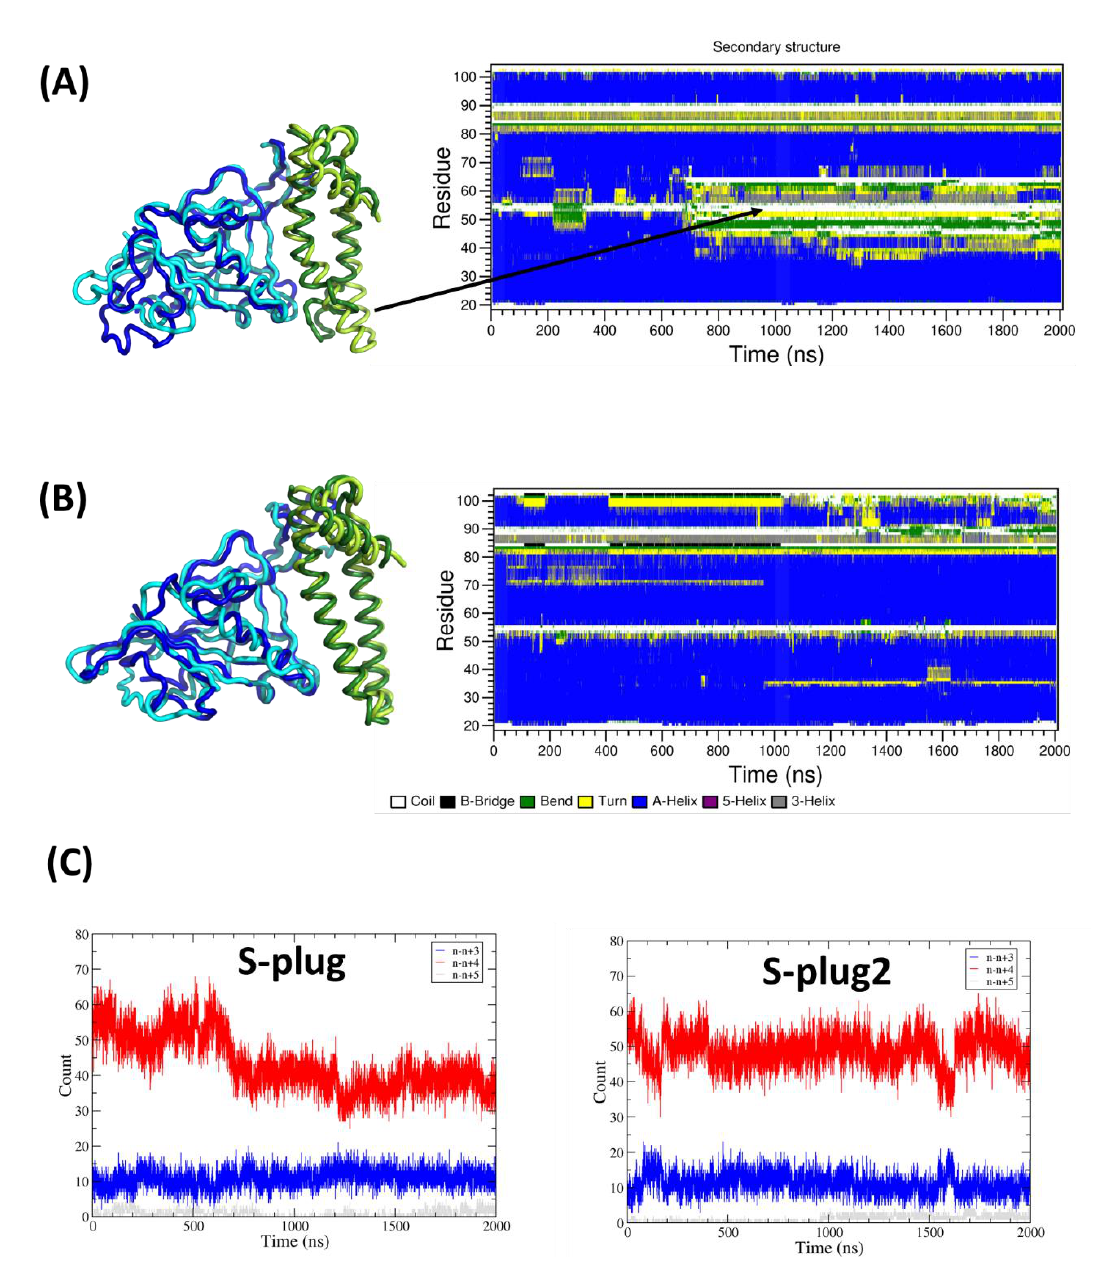
Figure 2. Molecular dynamics (MD) studies. ( A , B ) Secondary structure time evolution of S-plug and S-plug2, respectively, in the MD simulations complexes; best superimposition of the starting and average structures of the trajectories are reported on the left panels; RBD is shown in cyan/blue, S-plugs in yellow/green (starting/average); average structures (on Cα atoms) are computed over the entire trajectories . ( C ) Evolution of the number of hydrogen bonds in helical conformation in S-plug (left) and S-plug2 (right).